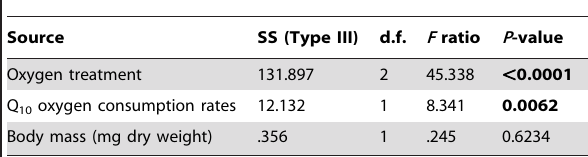
Table 1. Statistical analysis of critical thermal maxima